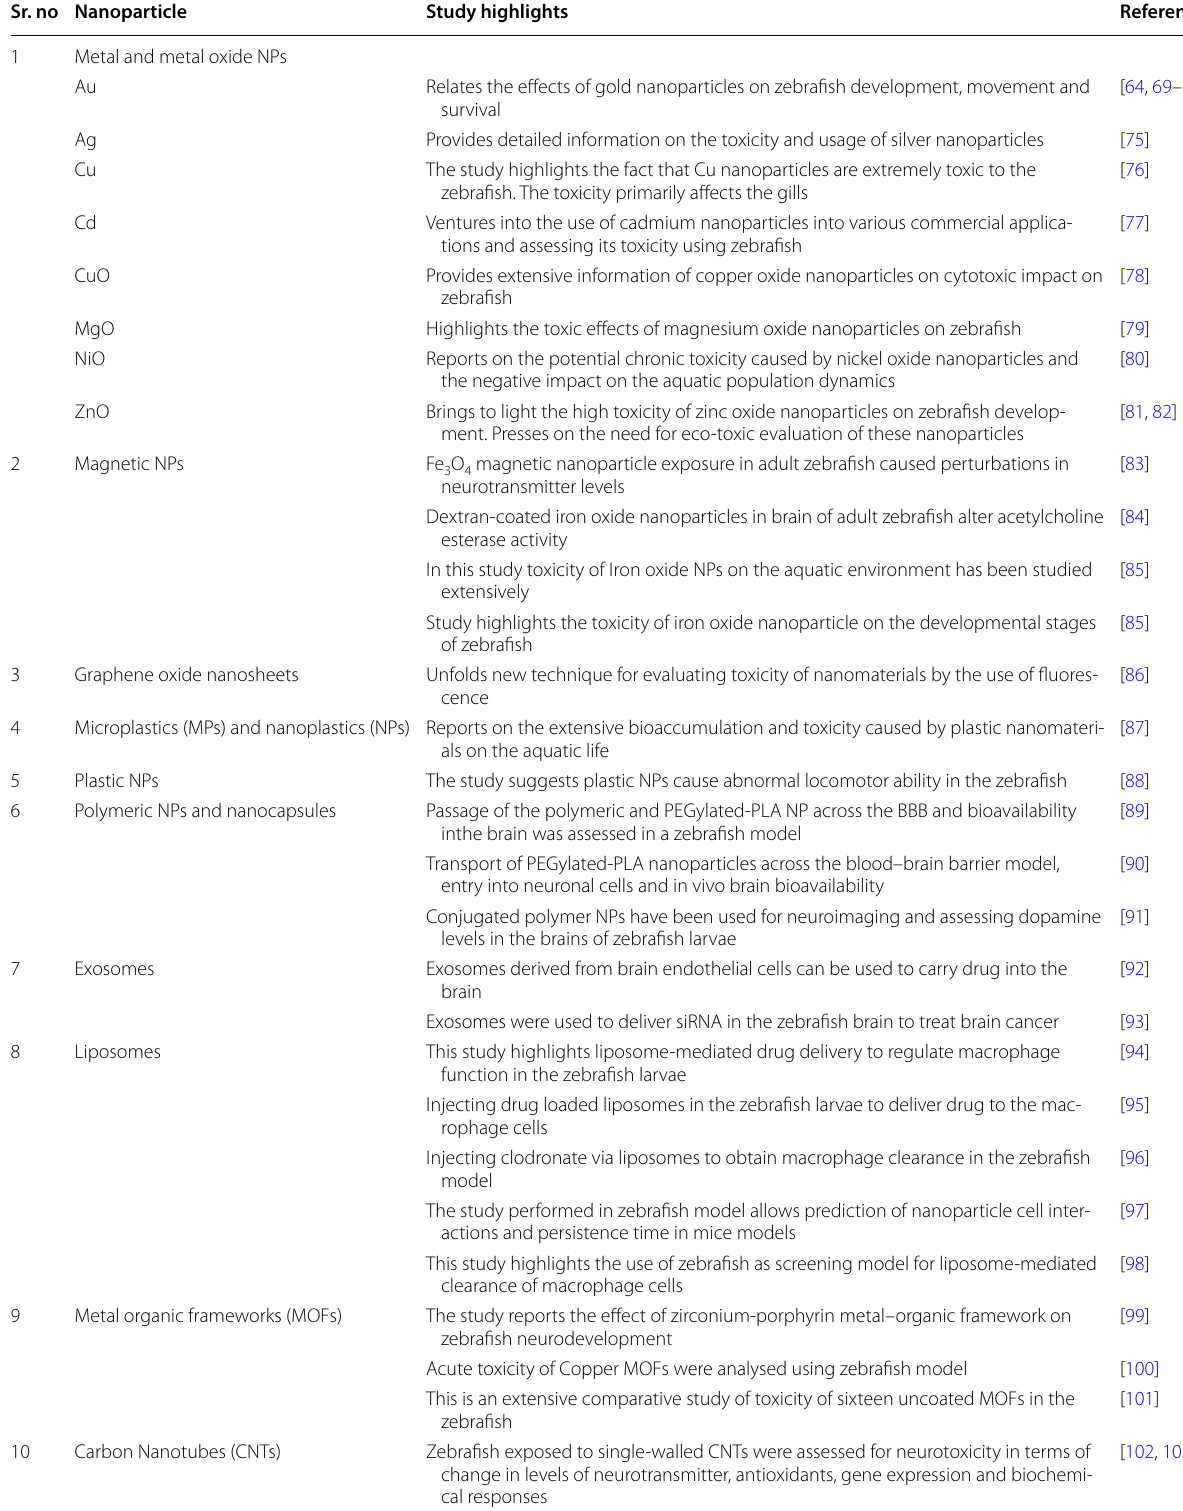
Table 1 A list of research done on nanocarrier neurotoxicity studies using zebrafish Sr. no